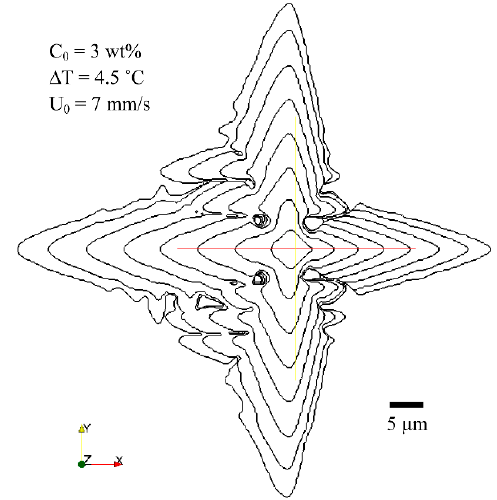
Figure 6. 2D sections showing the morphological changes of the 3D dendrite growing under melt convection. Snapshots were taken after 0.75 ms, 2.00 ms, 3.25 ms, 4.50 ms, 5.75 ms, 7.00 ms, 8.25 ms, and 9.00 ms of simulated time, starting from the innermost to the outermost contour. Figure 7 shows the velocity of the melt flow around the dendrite. The velocity is higher in the areas away from the dendrite and lower in the dendrite’s vicinity. The bottom portion of Figure 7 displays the solute concentration in two perpendicular sections through the center of the dendrite. As the solubility of solute in solid is lower than its solubility in liquid, an increasing amount of solute is rejected to the melt as the solidification progresses. At later times, when solidification is nearly complete, there are liquid regions enclosed by the solid phase, holding a high solute concentration. These regions may end up causing micro-segregation or forming eutectic phases.